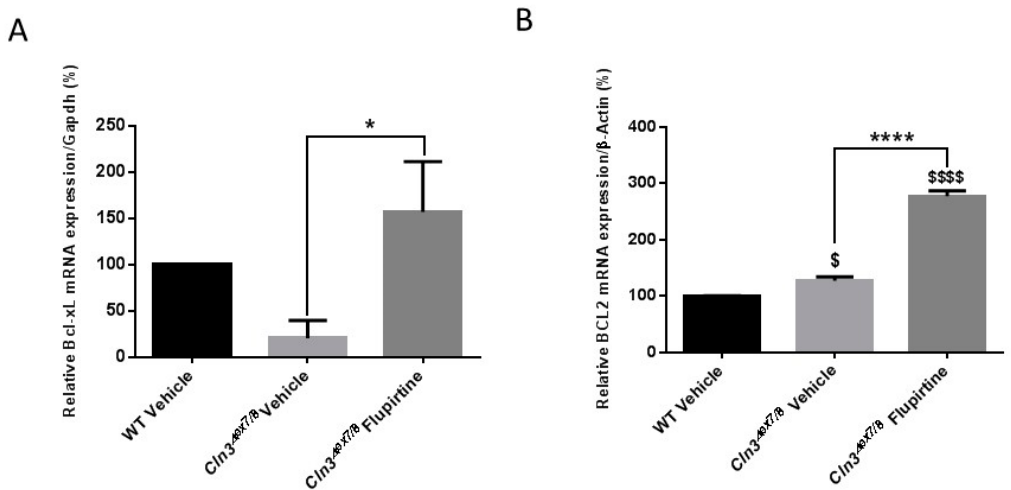
Figure 4. Mouse brain gene expression of anti-apoptotic markers. ( A ) Bcl-xl gene expression levels